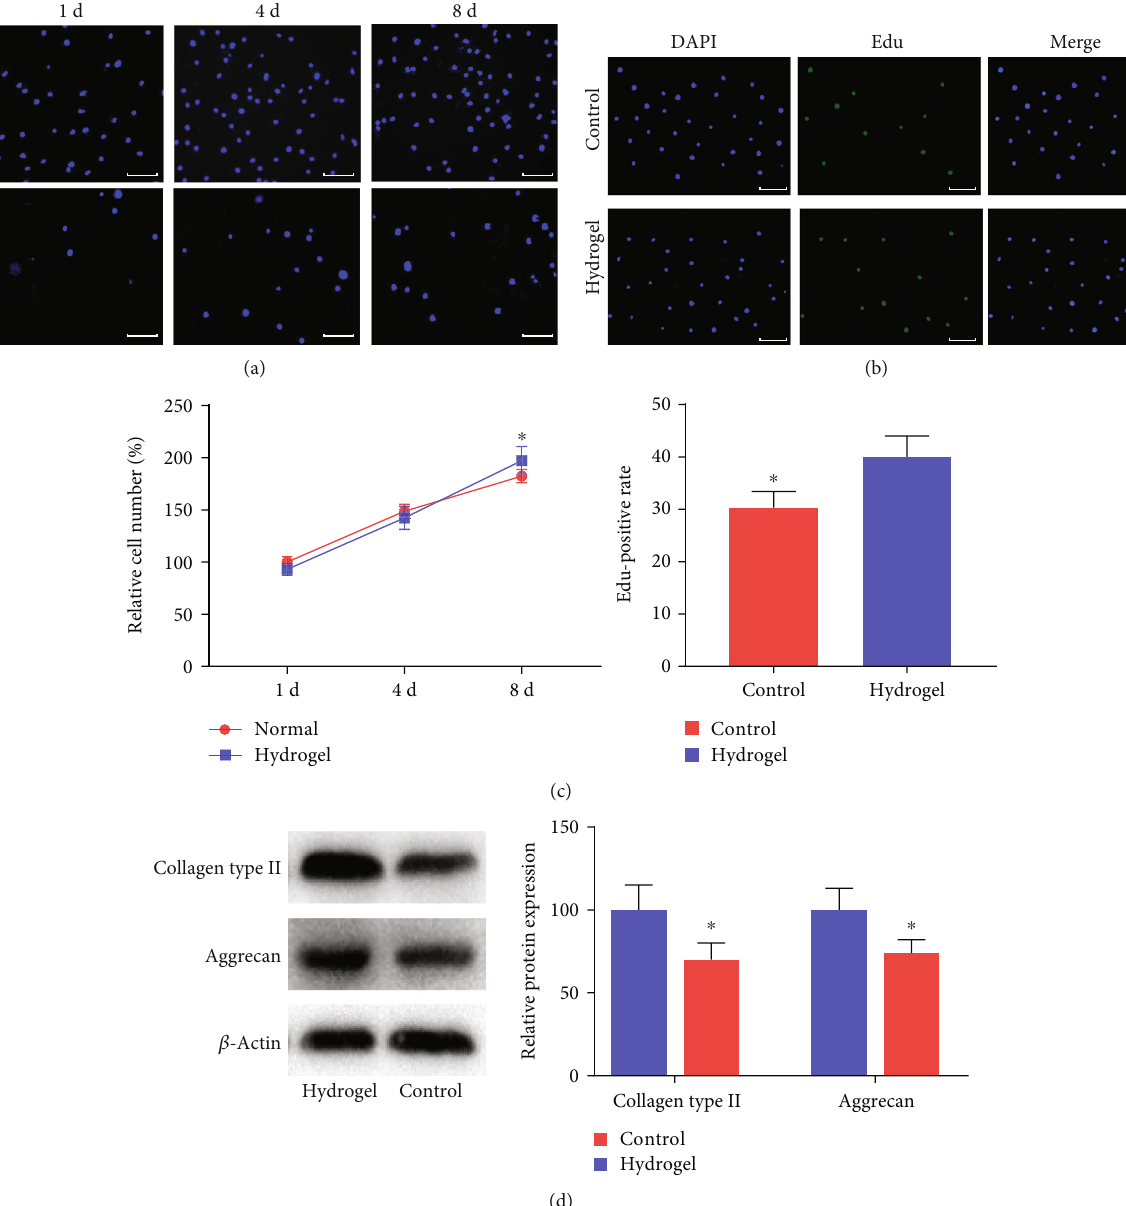
Figure 4: Cell proliferation and di ff erentiation. (a) Representative images of DAPI staining for 2D (control group) and 3D (hydrogel group) cultured NPMSC at 1, 4, and 8 days after cultivation. (b) Representative images of Edu staining for 2D (control group) and 3D (hydrogel group) cultured NPMSC at 8 days after cultivation. (c) Investigation of growth rate and Edu-positive rate of NPMSC culture for 8 days in the control group and hydrogel group. (d) Relative protein levels of collagen type II and aggrecan in the control group and hydrogel group. Data represent mean ± SD ; the error bars represent the standard deviation of measurements for 3 separate samples ( n = 3 ); ∗ p < 0 : 05 compared with the hydrogel group. White scale bar = 50 μ m